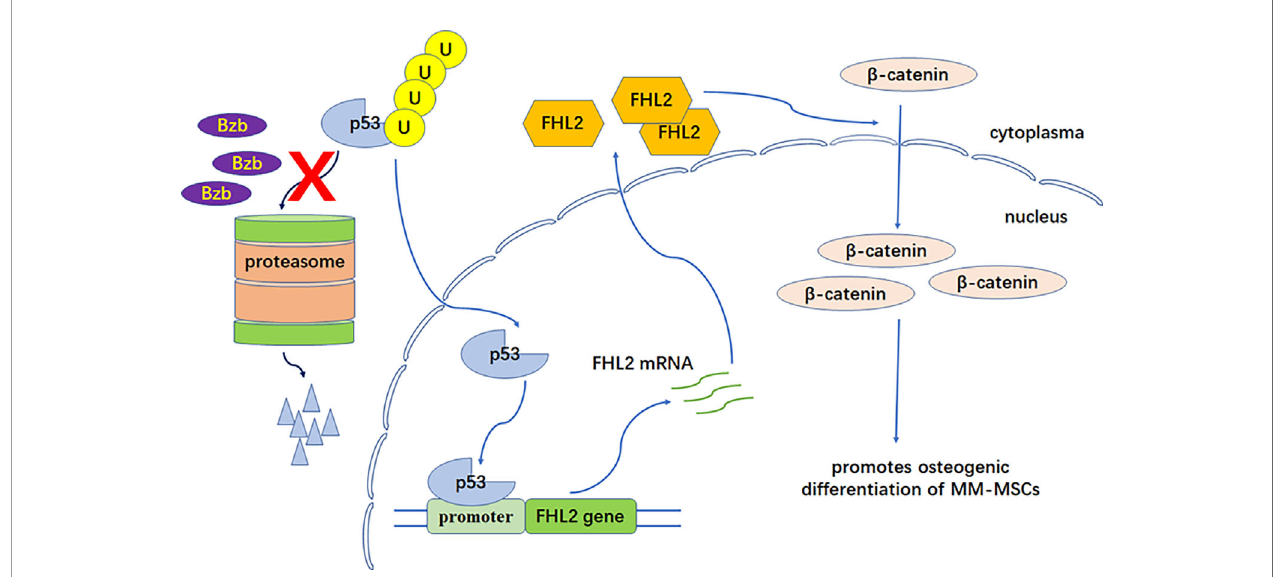
FIGURE 5 | FHL2 functional model in Bzb-induced osteoblast differentiation of MM-MSCs. P53 degradation is weakened with proteasome inhibition by Bzb. Upregulated p53 binds to the binding motifs in the promoter region of the FHL2 gene and promotes FHL2 expression. Finally, increased FHL2 changes subcellular localization of b -catenin (nuclear enrichment) and promotes osteogenic differentiation of